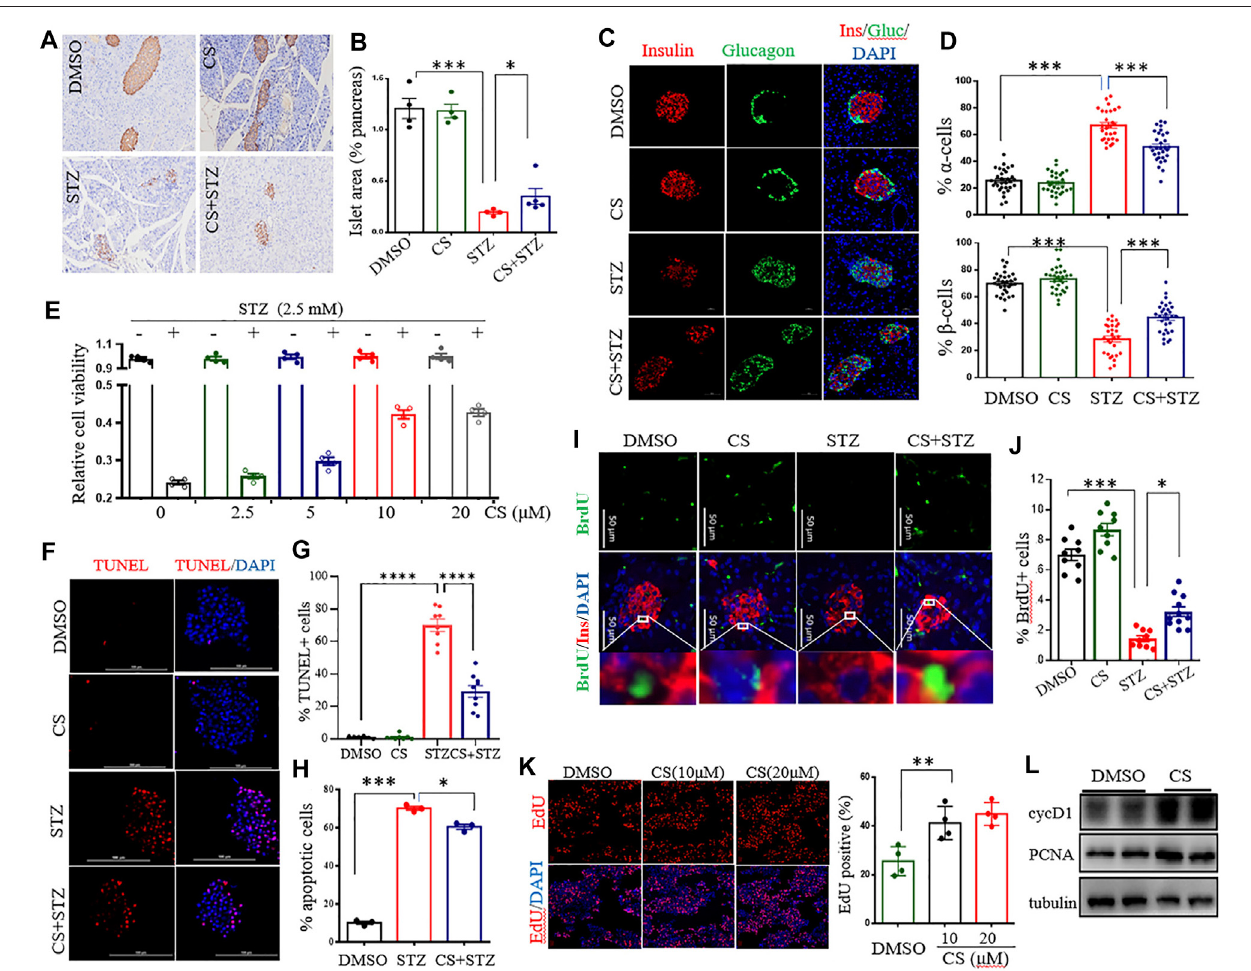
FIGURE 3 | CS preserved β -cell viability by enhancing cell proliferation and suppressing apoptosis. (A – D) Eight-week-old mice were subcutaneously injected with DMSO or CS (25 mg/kg body weight/dose, two doses daily) for 42 continuous days. STZ (40 mg/kg of body weight/day) was administrated subcutaneously daily for 4 days from the eighth day of the experimental treatment period. (A) Example immunohistochemical staining for insulin on formalin- fi xed paraf fi n-embedded pancreas, insulin staining appears brown. (B) Quantitative assessment of the islet area relative to the total pancreas. Each dot represents an individual mouse, one random pancreas section per mouse was examined ( n = 4 – 5 mice per group). (C) Maintained islet architecture as assessed by immunostaining analysis of pancreatic cryosections with antibodies against insulin ( β cells, red), glucagon ( α cells, green) and DAPI (nuclei, blue). Scale bars = 50 μ m. (D) Quantitative comparison of the proportion of glucagon-positive (upper chart) and insulin-positive (lower chart) cells in mice pancreatic islets. 25 – 40 islets were analyzed for each group ( n = 4 mice per group). (E) EffectsofCSonviabilityofINS-1 β -cellsexposedtoSTZ.FollowingpreincubationwiththeindicatedconcentrationofCSfor6 h,INS-1cellswerecoincubated withCSand2.5 mMofSTZfor12 h.CellviabilitywasdeterminedbyCCK-8assay. (F – H) EffectsofCSon β -cellapoptosis. (F,G) Isolatedmouseisletsweretreatedwith DMSO or CS (10 µM) or STZ (2.5 mM) or a coincubation of CS and STZ for 12 h β -cell apoptosis was measured by TUNEL and represented by percentage of TUNEL positivefortotalcells. (H) INS-1 β -cellapoptosiswasdetectedusinga fl owcytometricassaywithAnnexinVandPIstaining. (I – K) EffectsofCSon β -cellproliferation. (I,J) DoublestainingforBrdU(green)andinsulin(red)ofpancreatic β -cellsfrommicetreatedwithCSand/orSTZasindicatedinpanels (A – D,I) ,andtheproliferationof β -cells wasquanti fi edasthenumberofnucleifrombothBrdU-andinsulin-positivecellsdividedbythenumberofnucleifromonlyinsulin-positivecells (J) . (K) Theproliferationof INS-1 β -cells was measure by EdU incorporation staining from four to six independent experiments. (L) The expression of cell cycle regulators was determined by Western blotting. * p < 0.05, ** p < 0.01, *** p < 0.001.